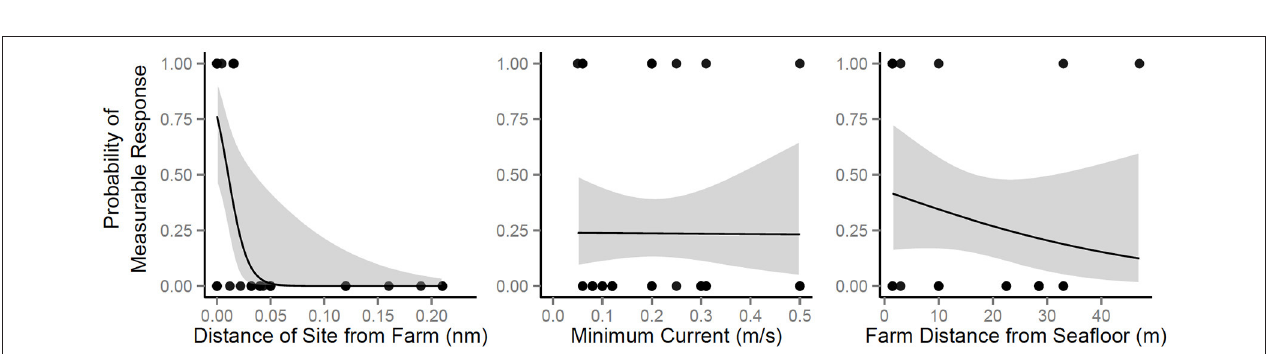
FIGURE 4 | The two most common metrics, minimum distance from shore (nm) and minimum depth (m). Depicted are the frequency distributions of the individual metrics (distance left panel; depth middle panel) and the articles that provided both distance and depth (right panel). The red dashed lines show the pre-assigned threshold for distance (3 nm) and depth (30m) comparisons.